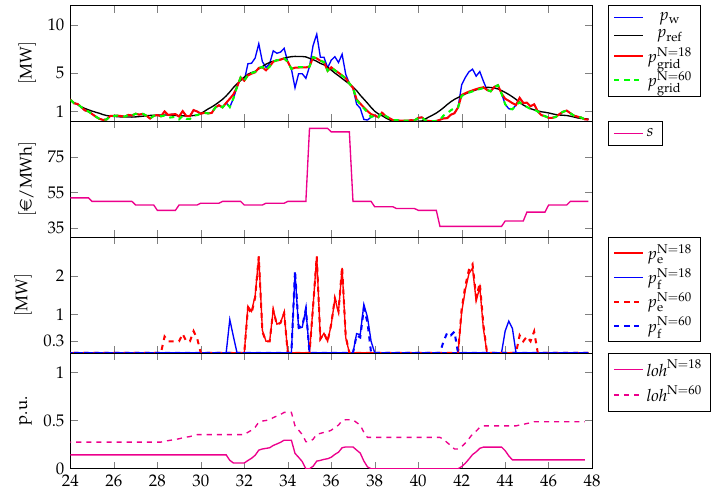
Figure 12. Different profiles related to the reference period from 09:00 of 30 May 2017 to the same hour of 31 May 2017, with full-feature operations: N = 18 vs. N = 60. First graph: power by wind generation (blue solid line), power reference that has to be delivered to the grid (black solid line), actual power delivered when N = 18 (red solid line) and actual power delivered when N = 60 (green dashed line); Second graph: spot market prices s (source: “Gestore dei Mercati Energetici s.p.a.—www.mercatoelettrico.org (accessed on 1 July 2022)”); Third graph: power of the electrolyzer when N = 18 (red solid line), power of the fuel cell when N = 18 (blue solid line), power of the electrolyzer when N = 60 (red dashed line) and power of the fuel cell when N = 60 (blue dashed line); Fourth graph: LoH when N = 18 (magenta solid line) and LoH when N = 60 (magenta dashed line).